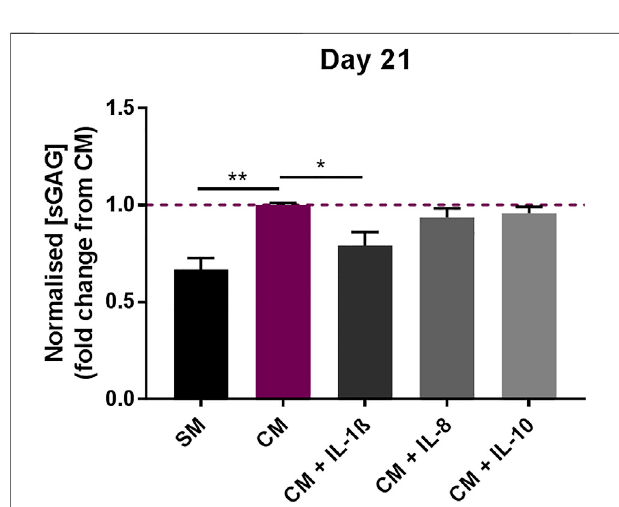
FIGURE 2 | Effects of IL-1 β (100 pg/ml), IL-8 (2 ng/ml) and IL-10 (100 pg/ml) supplementation on MSC chondrogenic response. sGAG concentration in MSC pellet cultures in the presence or absence of IL-1 β , IL-8 and IL-10 measured after 21 days, normalised to DNA content. Data shown as fold change compared to CM control condition. Error bars represent SEM. n = 4, * p < 0.05, ** p < 0.01.